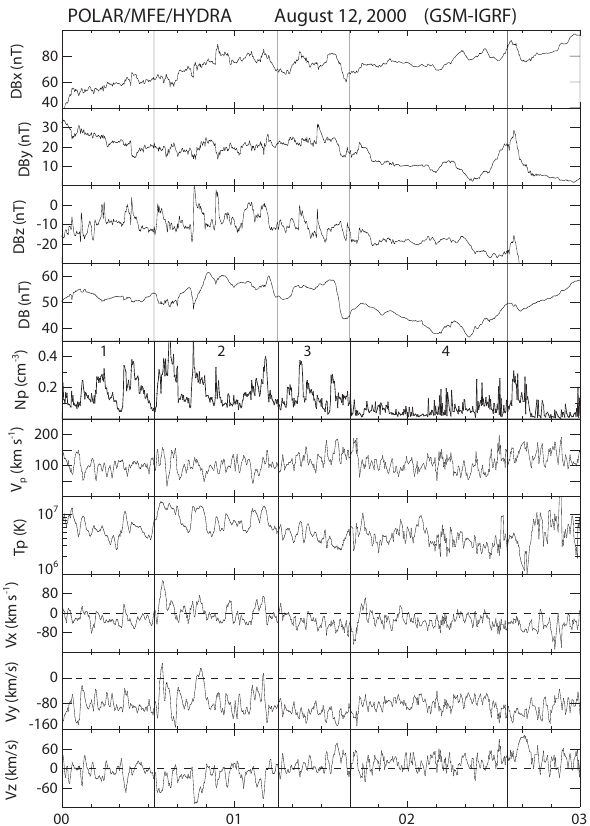
Fig. 9. Polar observations of magnetic deflections, plasma density, bulk speed, and the ion velocity components V x , V y , and V z shown in GSM coordinates. Subintervals are marked by vertical guide-